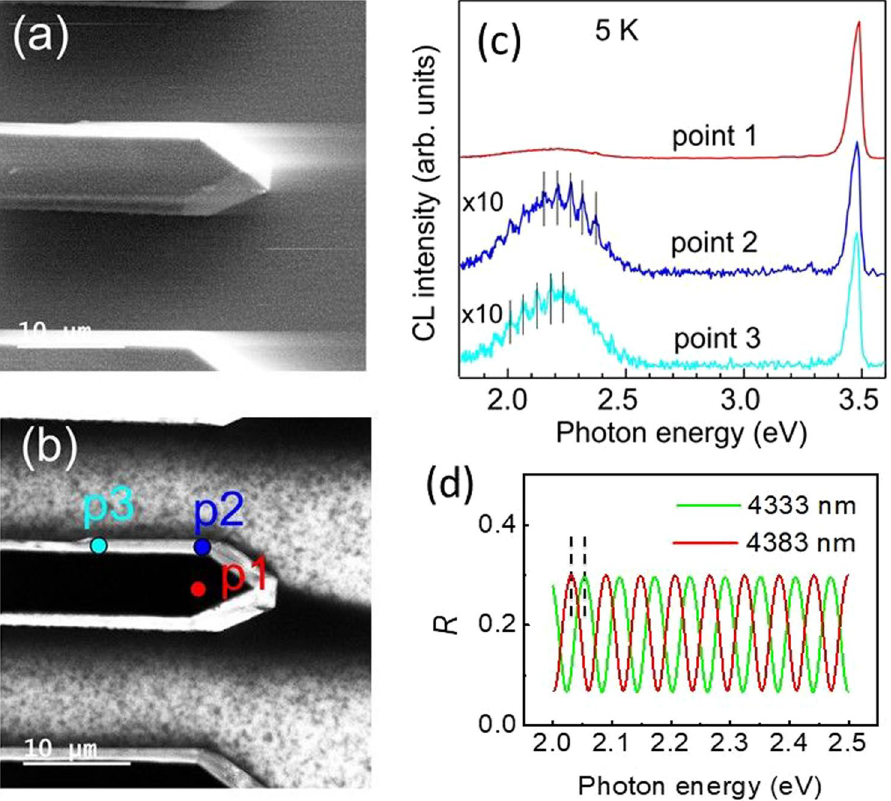
Figure 4. ( a ) SEM and ( b ) panchromatic CL images of the planar GaN nanowires with width of 6 µ m. ( c ) Low-temperature CL spectra measured at the same experimental conditions for different points on the stripe as indicated in the panchromatic CL image. Spectra are shifted vertically for clarity. ( d ) reflection spectra calculated according Eq. (12) for the GaN layer grown on sapphire with the layer thickness of 4333 and 4383 nm shown by green and red lines, respectively. Refractive index taken to 2.4 for GaN and 1.7 for sapphire. Vertical dashed lines show the energy shift of ~24 meV between interference maxima obtained for these